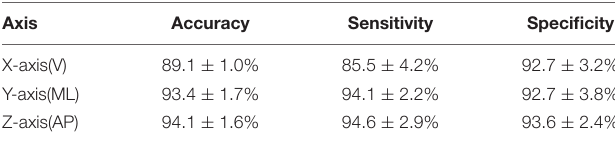
TABLE 5 | Classification results with the